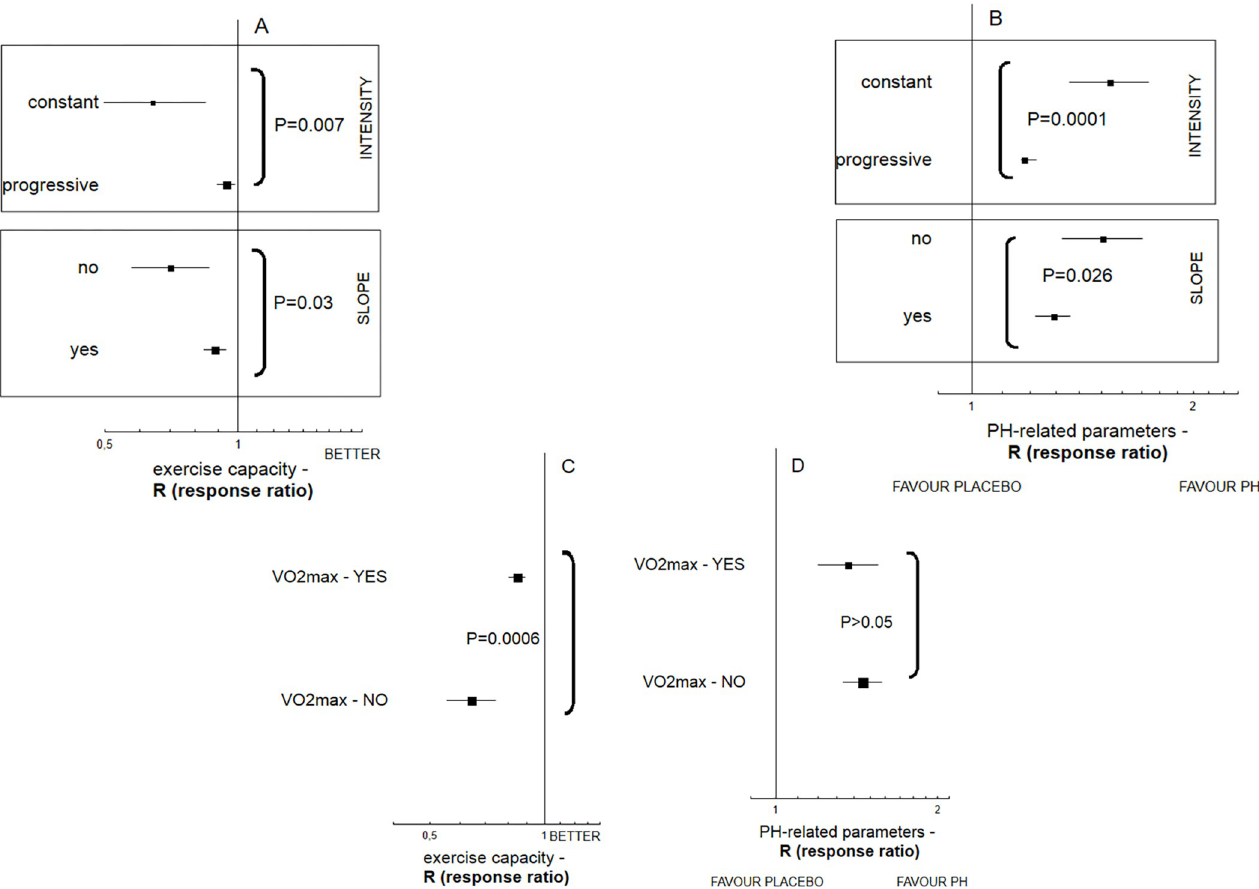
Fig 5. The influence of some methodological items that characterize training programs on the resulting exercise endurance of animals with PH and disease development (n = 753 animals). The overall effect was expressed as response ratio (R), according to alterations in both hemodynamic (RVSP, mPAP) and remodeling parameters (Fulton index, PA muscularization), as well as animal exercise capacity. The increased response ratio (R) values reveal worsening of PH-related parameters and better exercise endurance. A statistically significant Q measure (P < 0.05) indicates heterogeneity among two or more analyzed subgroups. Tree-plot for the effect size demonstrates better results in exercise tests that were achieved by animals that were exposed to a chronic training program (treadmill subgroup) that included progressively increased speed (Q = 7.18; df = 1; P = 0.007) and incline (Q = 4.74; df = 1; P = 0.03) ( A ); and when the training intensity was adjusted to VO 2 max parameter, assessed individually (Q = 11.8; df = 1; P = 0.0006) ( C ); increasing intensity and slope were also related to less development of PH-related parameters in training subjects (Q = 16.1; df = 1; P < 0.0001 and Q = 4.9; df = 1; P = 0.026, adequately) ( B) ; any significant impact of individually matched training program (adjustment to VO 2 max) was not denoted for PH development ( D